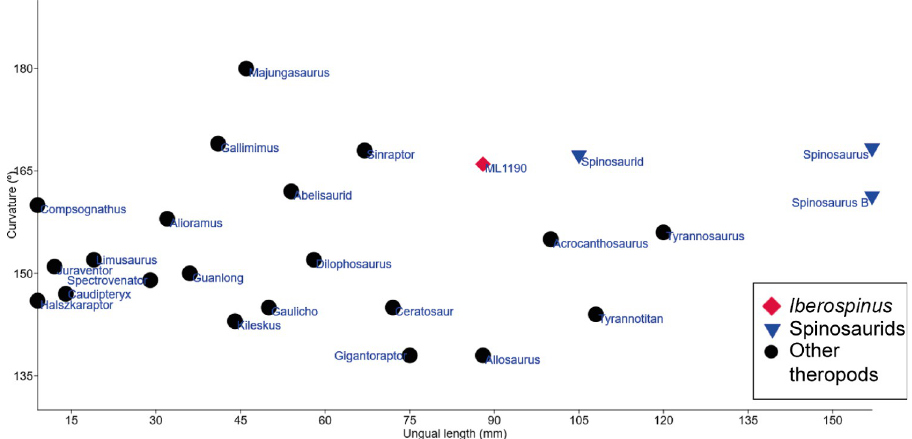
Fig 29. Curvature vs length of the ungual of Iberospinus natarioi (ML1190-34) compared with other theropods. ML1190-34, red diamond; Spinosauridae , inverted blue triangles; other theropods , black dots. Curvature is in degrees and length is in